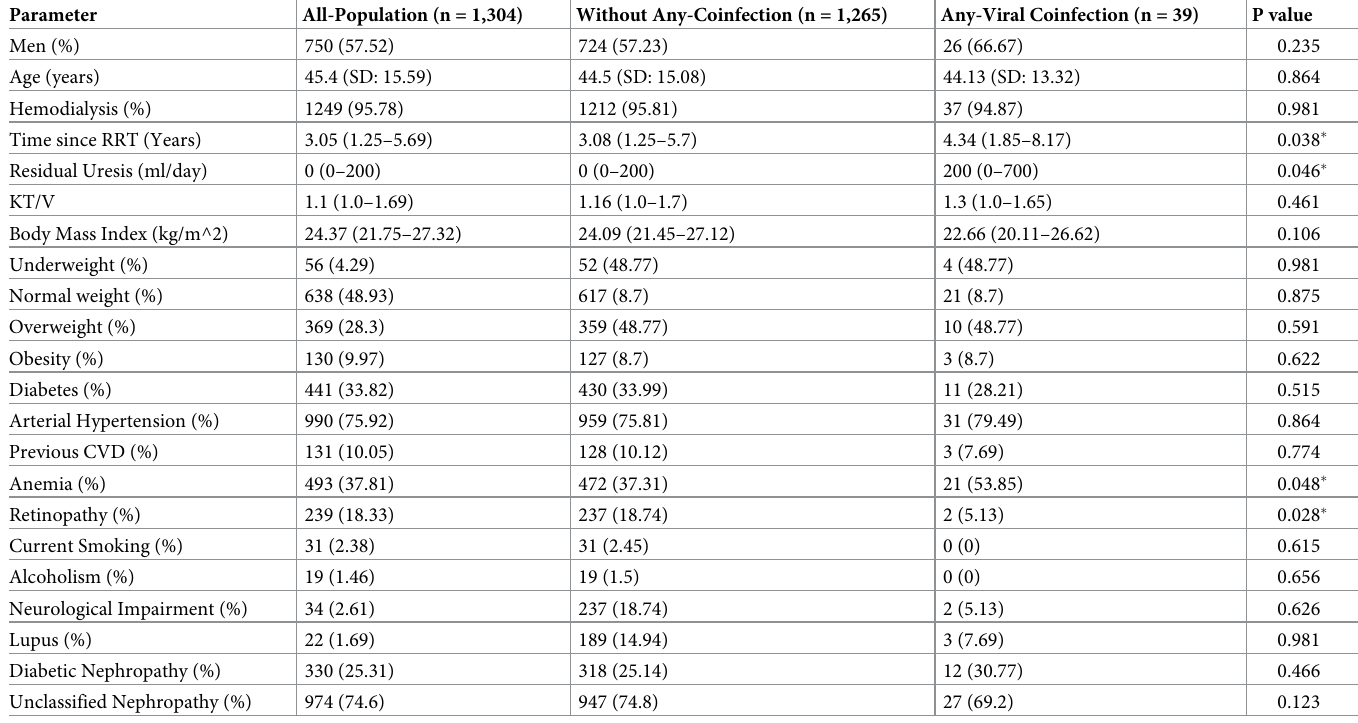
Abbreviations : RRT = renal replacement therapy; CVD = cardiovascular